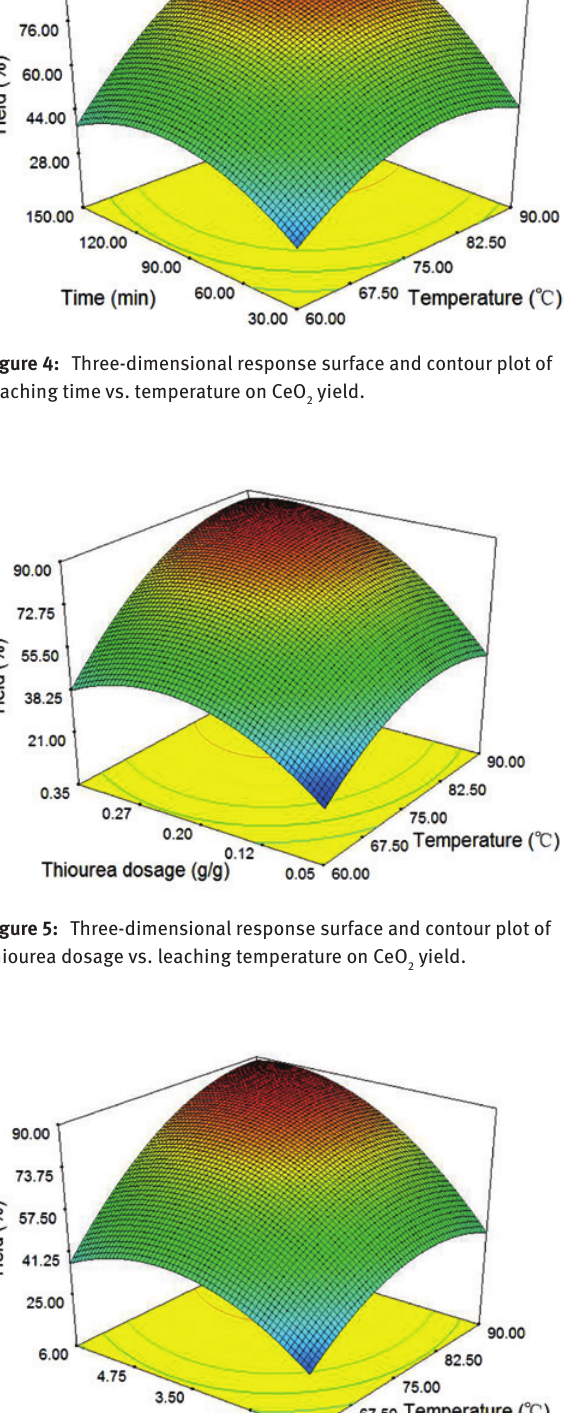
Figure 6: Three-dimensional response surface and contour plot of HCl concentration vs. leaching temperature on CeO